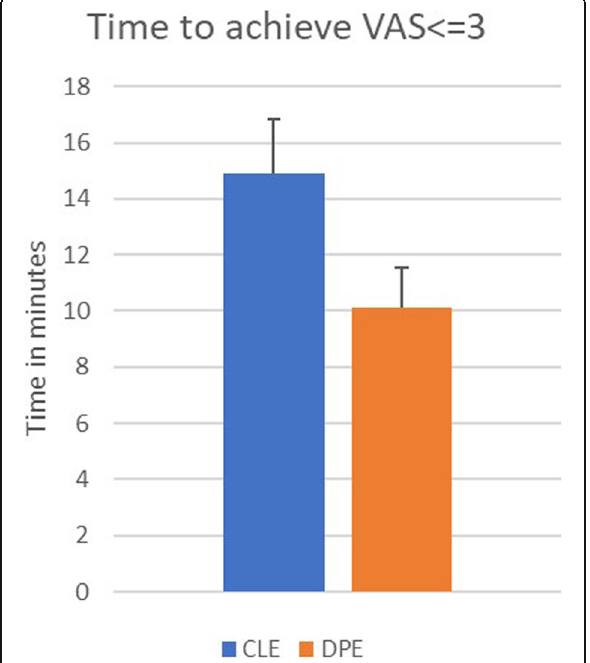
Fig. 2 Time to achieve a reduction in VAS > 50% in the study groups: 7.06 ± 0.79 min in group CLE and 5.0 ± 1.06 min in group DPE ( p < 0.0001). CLE conventional lumbar epidural, DPE dural